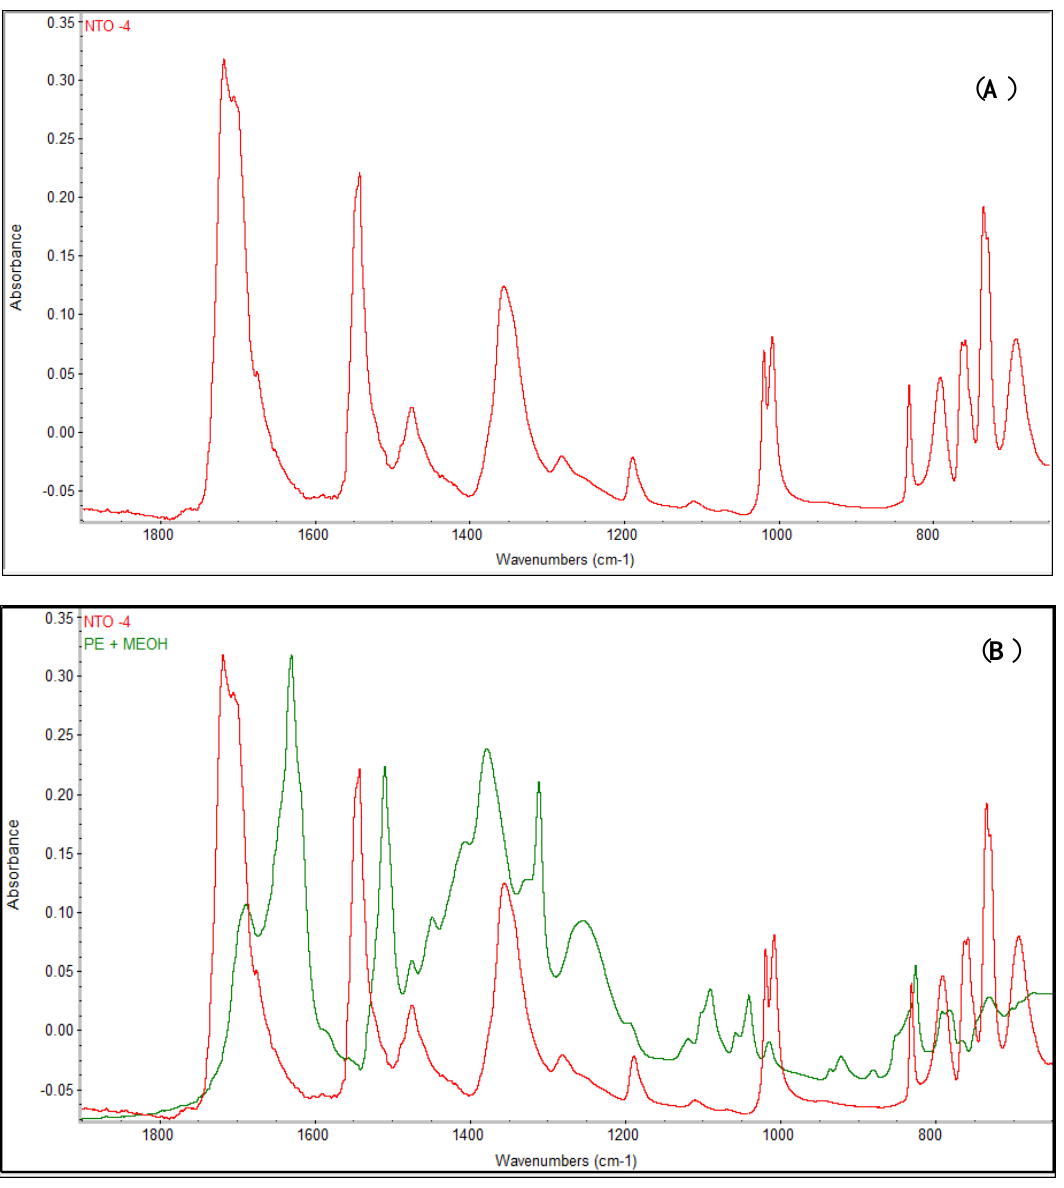
Figure 7. FTIR spectra of ( A ) pure NTO solid, and ( B ) both solid NTO and plant exudates. Peaks at 1800–1600 cm −1 (for C=O bonds), 1550–1500 cm −1 , and 1372–1290 cm −1 (for N-O bonds) are distinct for NTO. All three distinct peaks were also visible for plant exudates.